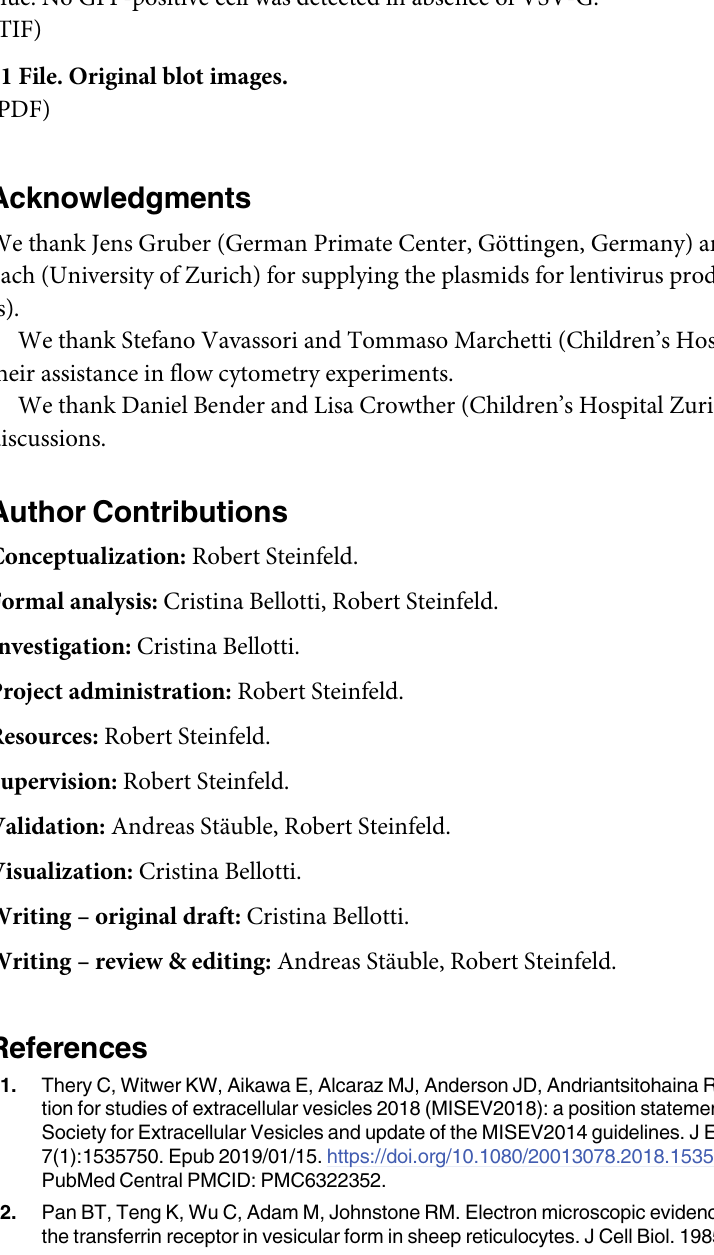
S1 Fig. GFP-CD9 expression in stable cell line. Cells from the GFP-CD9+ cell line were stained with Hoechst 33342 1:2,000 (in blue). Images were taken with a 40X objective. Expres- sion of the fusion protein can be seen located to the cell membrane. (TIF) S2 Fig. Expression of FR α and CD9 in FR α +/CD9+ line compared to WT. HSP90 was used as loading control. (TIF) S3 Fig. Example of transduction with LVs produced in WT, FR α + or FR α +/CD9+ cells. Images were taken 72h after transduction. GFP signal is shown in green, Hoechst 33342 in blue. No GFP-positive cell was detected in absence of VSV-G. (TIF) S1 File. Original blot images.